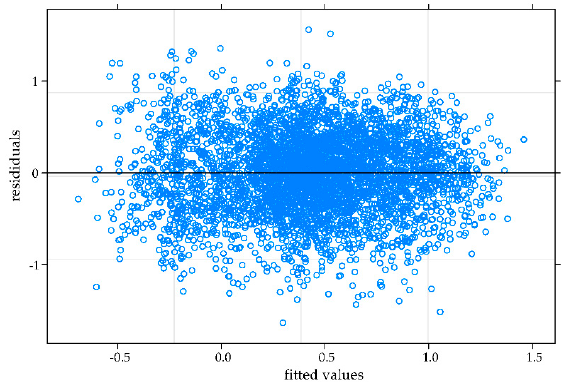
Figure A2. Scatter plot of the model residuals versus fitted values of the linear mixed-effects model for the four tree species.